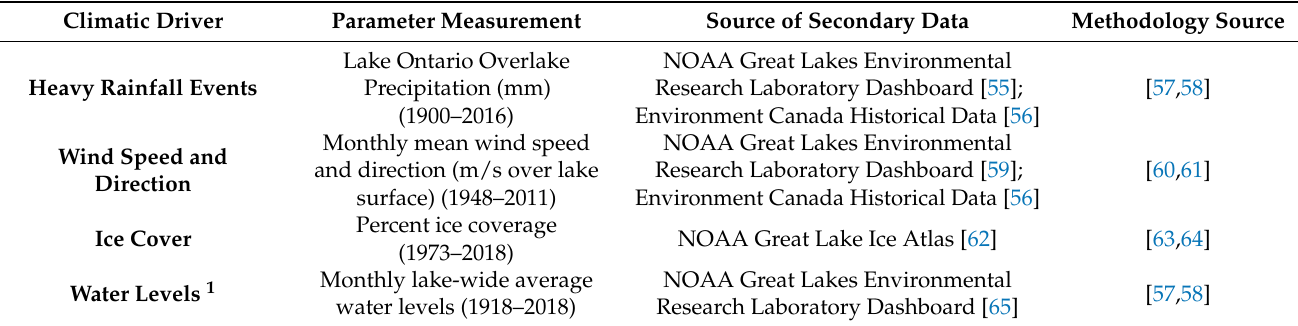
Table 4. Climatic drivers of change to be investigated, sources of data, and methodological justification.